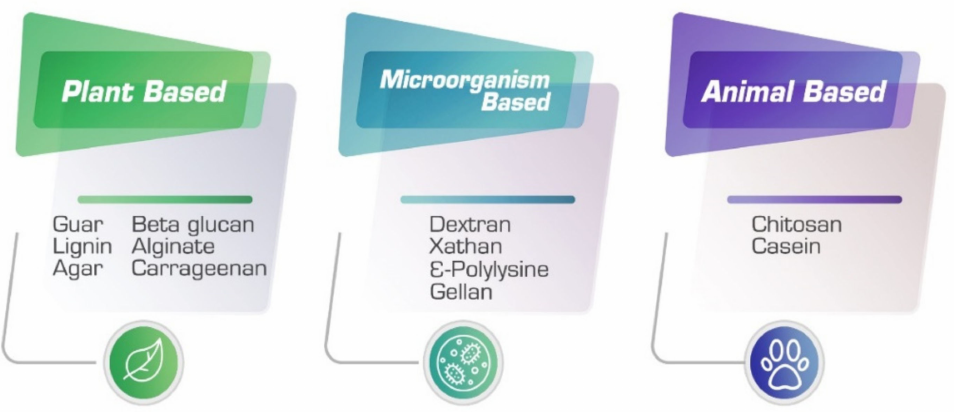
Figure 1. Common biopolymers used for soil improvement based on their source of